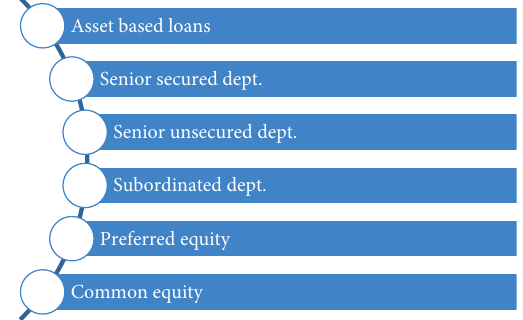
Figure 8: The general trend of optimization of capital structure in infrastructure